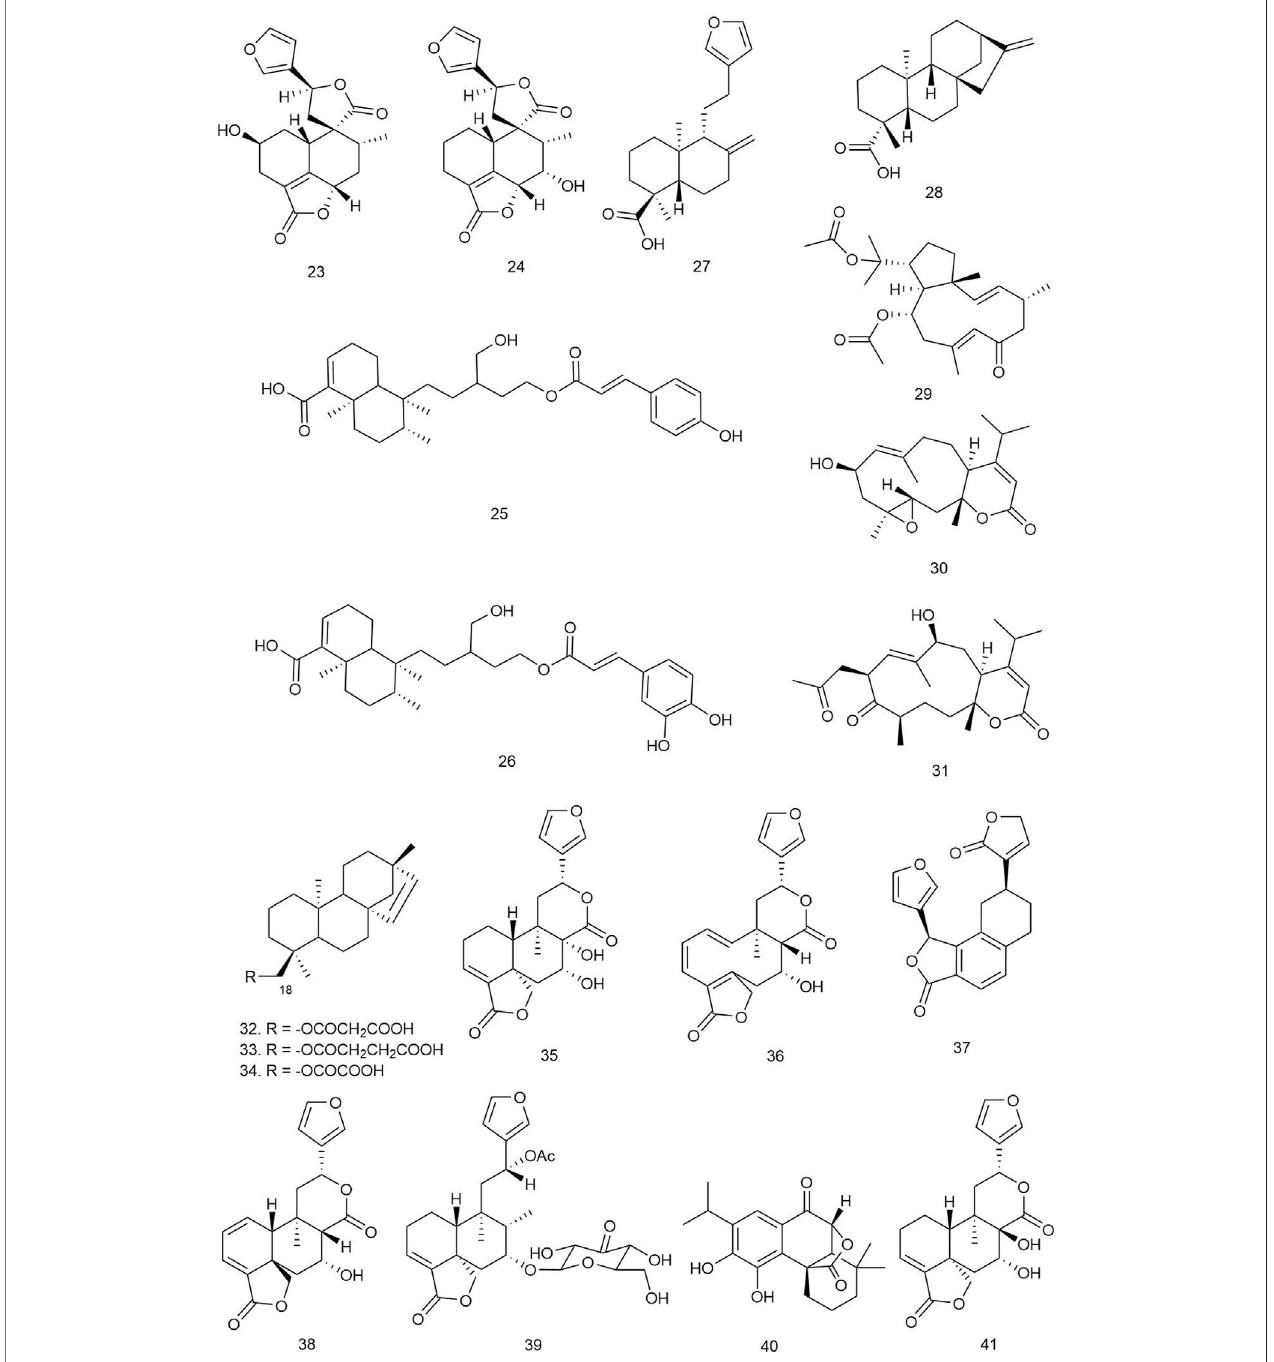
FIGURE 3 | Structures of clerodane, copaiba, dolabellane, ent -beyerene, and furano diterpenoids with signi fi cant antibacterial activity.